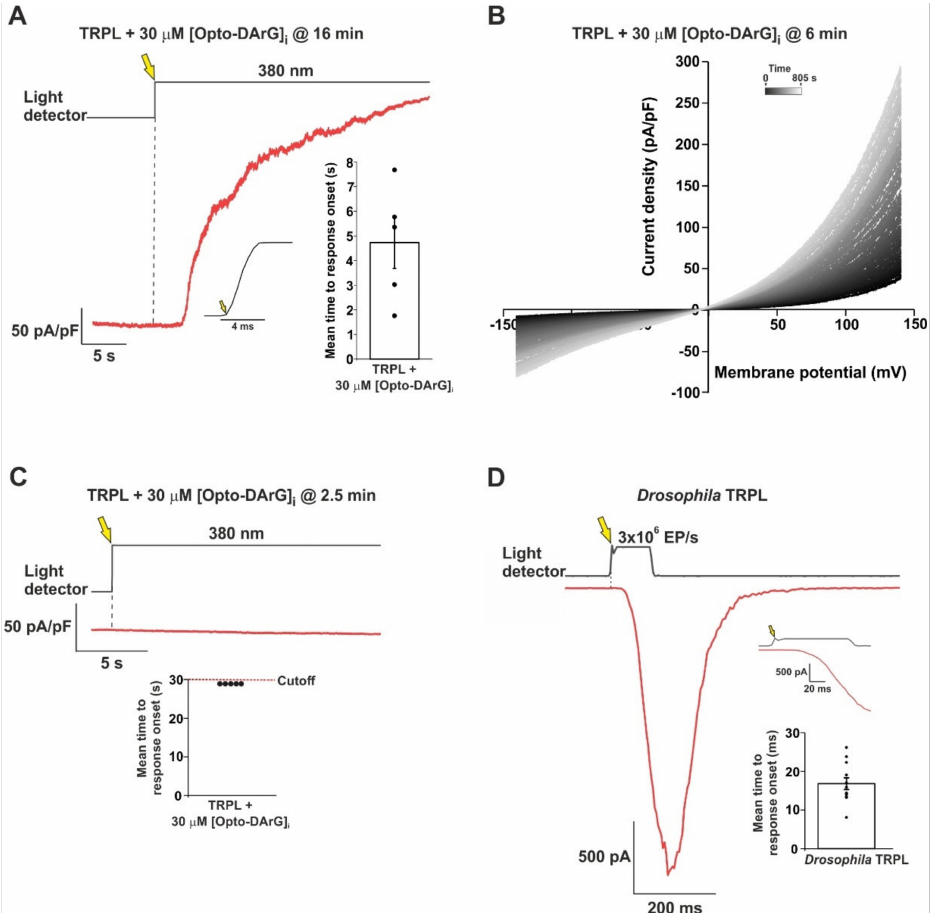
Figure 3. Activation of TRPL channels expressed in HEK cells by an optically controlled DAG analogue in comparison to light activation of Drosophila TRPL. ( A ) A representative current as a function of time showing an outward current induced by an intense UV (380 nm) light applied to an HEK cell expressing the TRPL channel, in which 30 µ M OptoDArG was included in the intracellular solution of the patch clamp pipette. The UV light was applied 16 min after whole cell formation, while the cell was kept in the dark during that time to keep the OptoDArG in its inactive trans configuration. Then, the membrane voltage was increased in the dark from 0 mV to +100 mV holding potential and the UV light was turned on, resulting in a robust outward current (red trace). The upper black trace depicts the onset of the UV (380 nm) light measured by a light detector. The yellow arrow and the dashed line indicate the time of UV light onset. Left inset, the accurate open time of the electromechanical shutter, which allowed the accurate application of UV light as measured by the light detector . Right inset , a bar chart showing the mean time to response onset as measured from the turn-on time of the UV light to the initiation of the outward current ( n = 5). Error bar shows SEM. Values from individual experiments are shown (circles). ( B ) A cluster of representative i-V curves obtained from patch clamp whole cell current measurements of a T-REx cell expressing TRPL, in response to voltage ramps from − 150 mV to +150 mV, following intracellular application of 30 µ